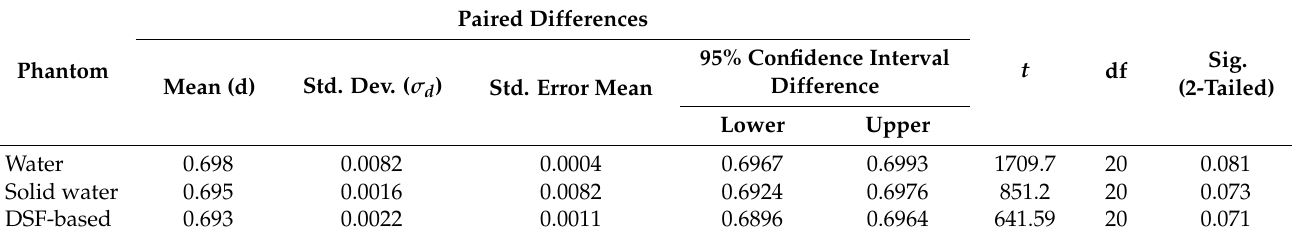
Table 8. Paired t -test of the TPR 20,10 measurement for 6 MV photons.